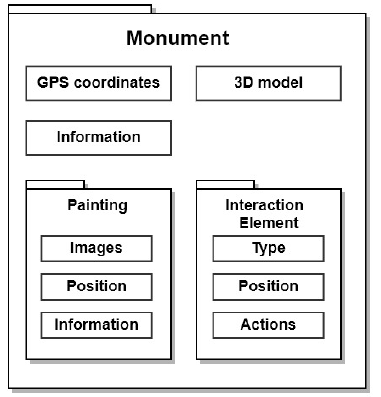
Figure 9. The system’s information model, and Monument